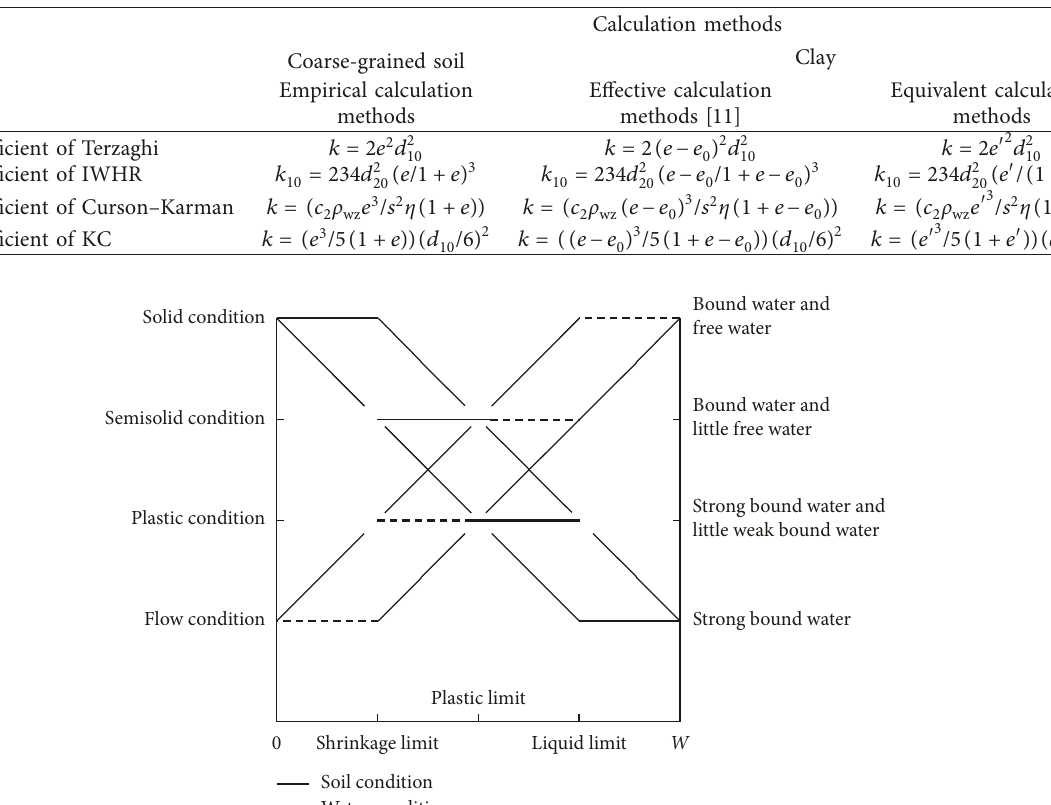
Table 5: Calculation methods of the seepage coefficient for coarse-grained soil and clay.